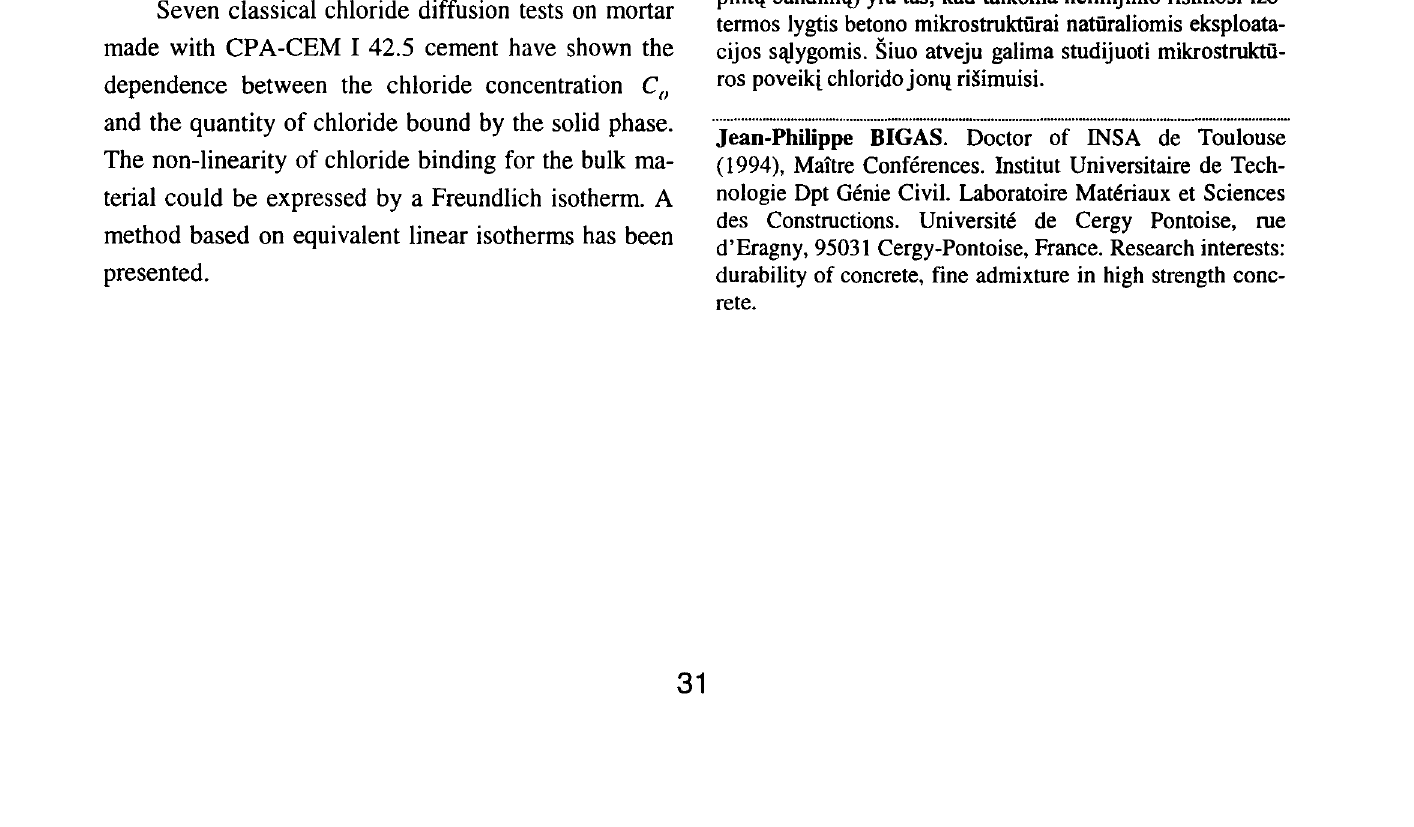
The straight line equation is: aeq = 0.149+2.73 so we get a= 1.34.10- 3 .